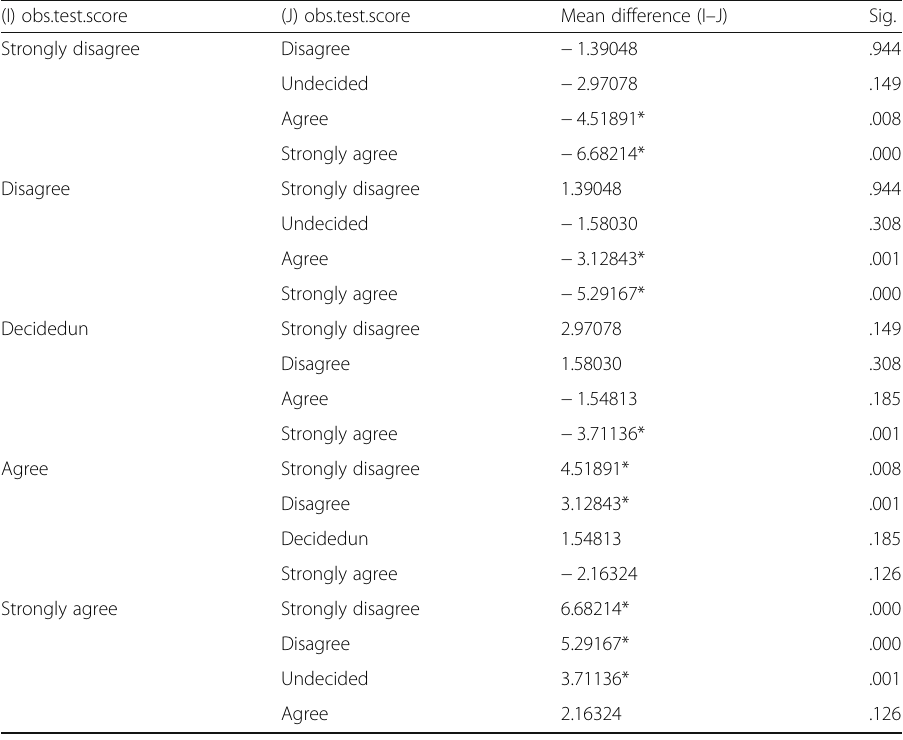
Table 8 Results of post hoc analysis using Tamhane test for multiple comparisons among groups in the TOEFL iBT